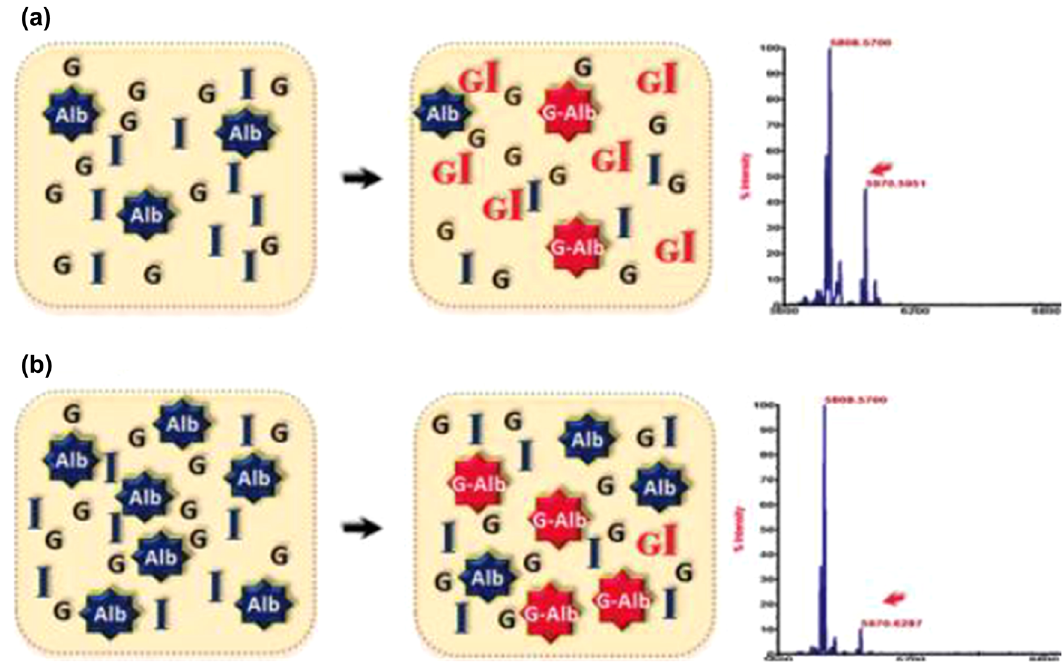
Figure 2: ( a ) At low albumin levels, the relative intensity of glycated insulin is higher, and ( b ) at high albumin levels, the relative intensity of glycated insulin decreased, as albumin competes for glycation because of its high abundance. I – insulin, Alb – albumin, G – glucose, GI – glycated insulin, G - Alb – glycated albumin. Reprinted with permission from Bhonsle et al. [ 65 ] . Copyright 2012, American Chemical